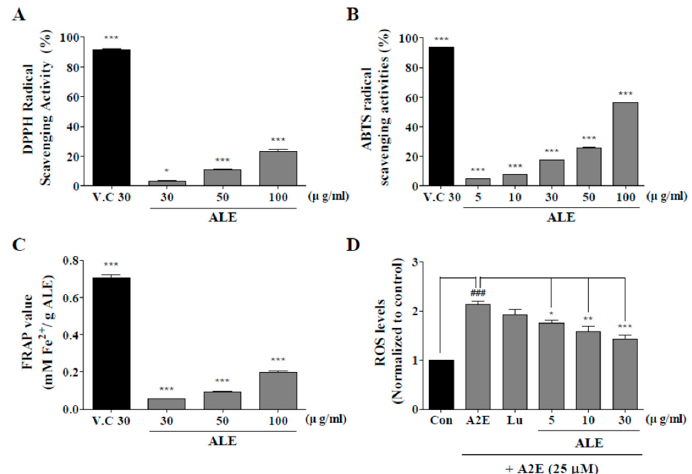
Figure 2. Antioxidant activity of ALE. 2,2-diphenyl-1-picrylhydrazyl (DPPH) radical scavenging assay ( A ),2,2’-azino-bis(3-ethylbenzothiazoline-6-sulfonicacid)(ABTS)radicalscavengingassay( B ),andferric reducing antioxidant power (FRAP) assay ( C ) were used to monitor the antioxidant activities of ALE at di ff erent doses. ( D ) ARPE-19 cells, a human retinal pigment epithelial cell line, were treated with ALE prior to N-retinylidene-N-retinylethanolamine (A2E) and intracellular reactive oxygen species (ROS) generation was monitored with the use of 5-(and-6)-chloromethyl-2 (cid:48) ,7 (cid:48) -dichlorodihydrofluorescein diacetate, acetyl ester (CM-H 2 DCFDA). The values represent the mean ± SD ( n ≥ 3). * p < 0.05, *** p < 0.001 vs blank group, one-way ANOVA with Tukey’s post hoc